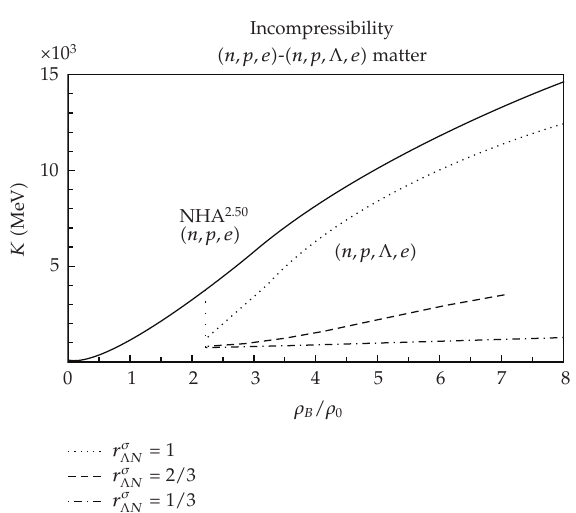
Figure 7: Incompressibilities of (cid:7) n,p,e (cid:8) and (cid:7) n,p, Λ ,e (cid:8) . The discontinuity of incompressibility occurs at k F (cid:5) 1 . 7fm − 1 , because of the phase transition from (cid:7) n,p,e (cid:8) to (cid:7) n,p, Λ ,e (cid:8) . ρ 0 is the saturation density of symmetric nuclear matter.